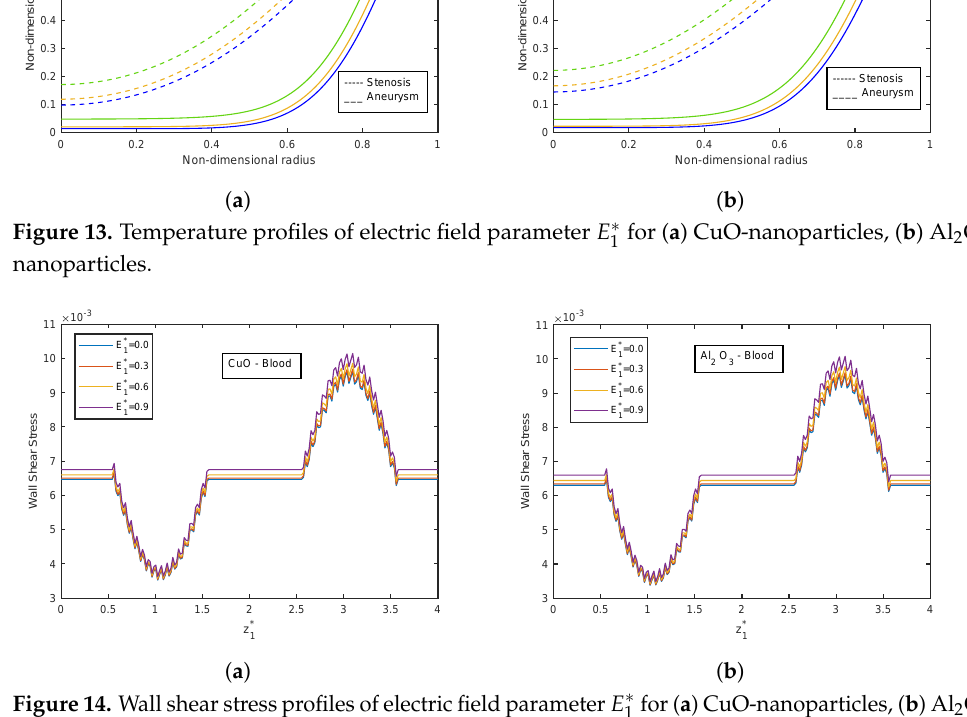
for ( a ) CuO-nanoparticles, ( b ) Al 2 O 3 - 1